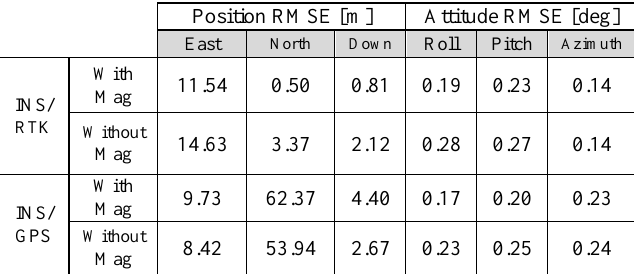
Table 5. ADIS PA RMSE for magnetometer aiding, GPS and RTK position update during satellite signal